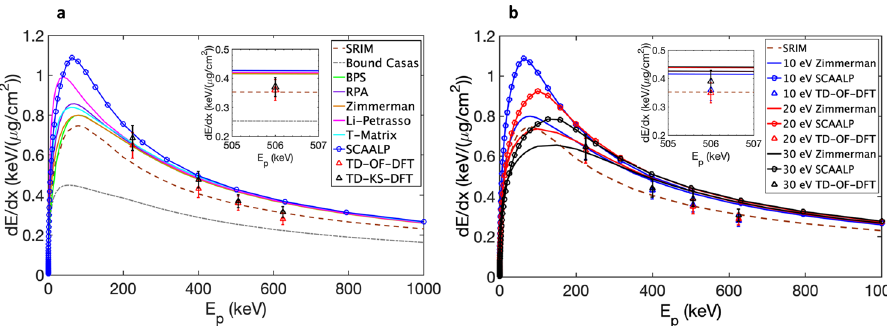
Fig. 5 Comparisons of proton stopping power in warm dense carbon. a Stopping power for ρ = 0.5 g/cm 3 and T e = 10 eV. b Stopping power for ρ = 0.5 g/cm 3 and various temperature values T e = 10 eV, 20 eV and 30 eV. The error values of TD-OF-DFT and TD-KS-DFT results from